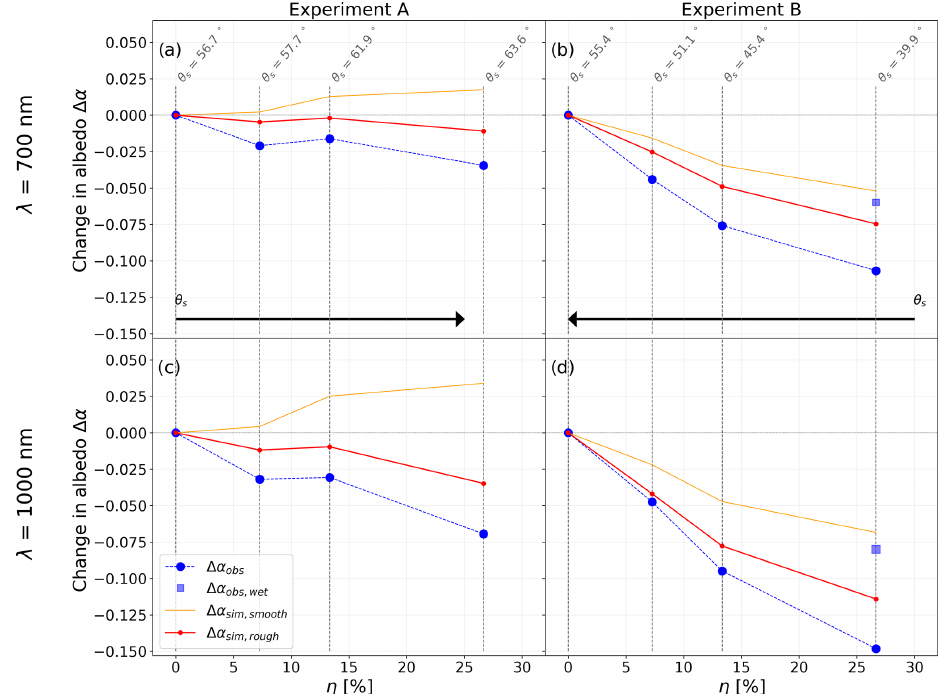
Figure 7. Variations in albedo differences between the albedo at θ s and the albedo at θ s , o , corresponding to that of the smooth surface, as a function of the η ratio ( W/(cid:51) in %). Blue points are (cid:49)α obs ( λ,θ s ) ( = α obs ( λ,θ s )– α obs ( λ,θ s , o )), and orange lines are (cid:49)α sim , smooth ( = α sim , smooth ( λ,θ s )– α sim , smooth ( λ,θ s , o )) , where variations are due to θ s changes only ( η = 0% for all simulations) and red lines are (cid:49)α sim , rough ( = α sim , rough ( λ,θ s )– α sim , smooth ( λ,θ s , o )), which varies with η and θ s . Blue squares are the (cid:49)α obs , wet ( λ,θ s ) ( = α obs ( λ,θ s )– α obs , wet ( λ,θ s , 0 )), where α obs , wet is the measured albedo over the B smooth–wet surface ( η = 0% and θ s = 39 . 9 ◦ ; Table 1). Grey vertical lines describe the solar zenith angle ( θ s ) when measurements were acquired. Results are given for (a) experiment A at 700nm. (b) Same as (a) but for experiment B and (c) experiment A at 1000nm. (d) Same as (c) but for experiment B.